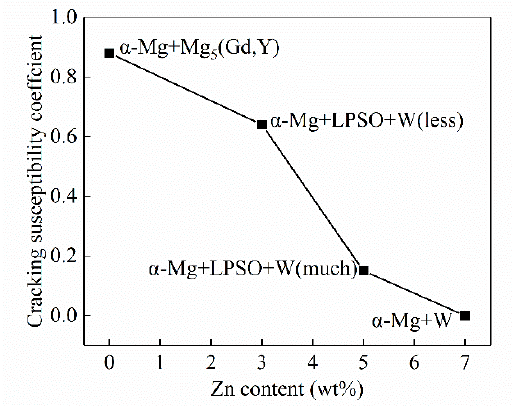
Figure 9. Predicted CSC values of Mg–7Gd–5Y– x Zn–0.5Zr alloys.